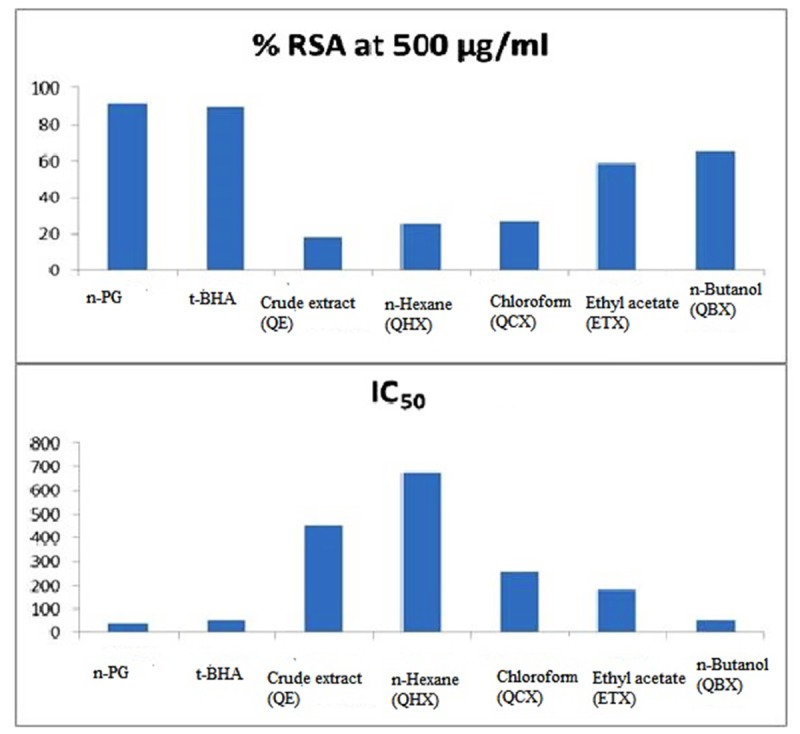
Antioxidant activity in % RSA and IC50.